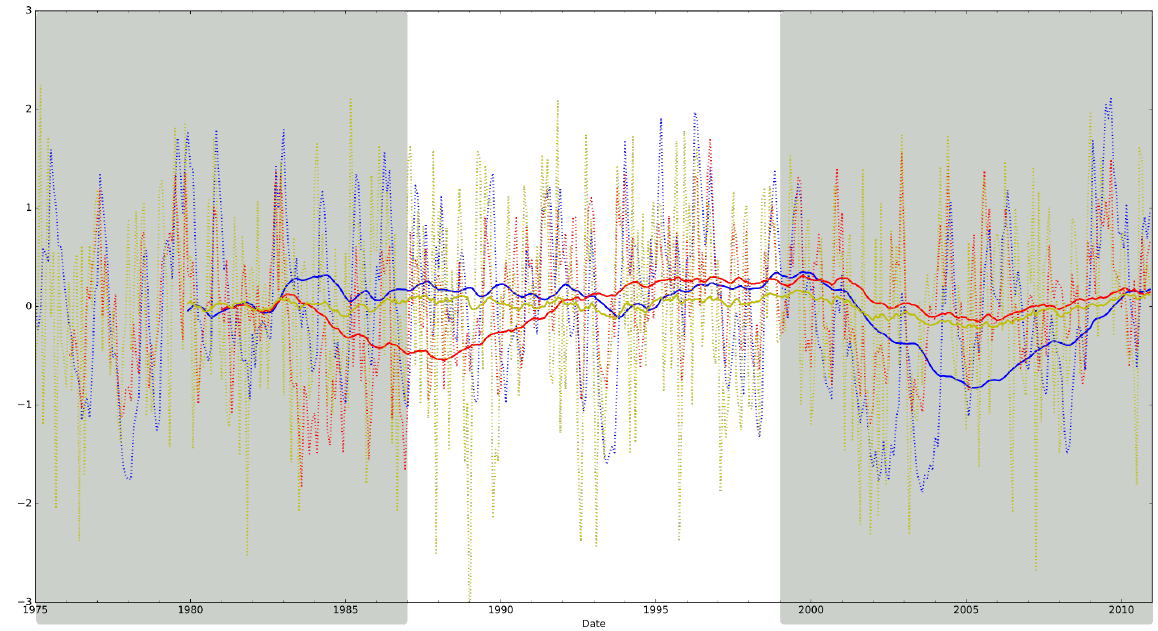
Figure 8. Average values (dotted lines) for the SGI (blue), SPI1 (yellow) and SRSI (red) and their 5-year-running means (solid lines) for the Leibnitzer Feld subregion.